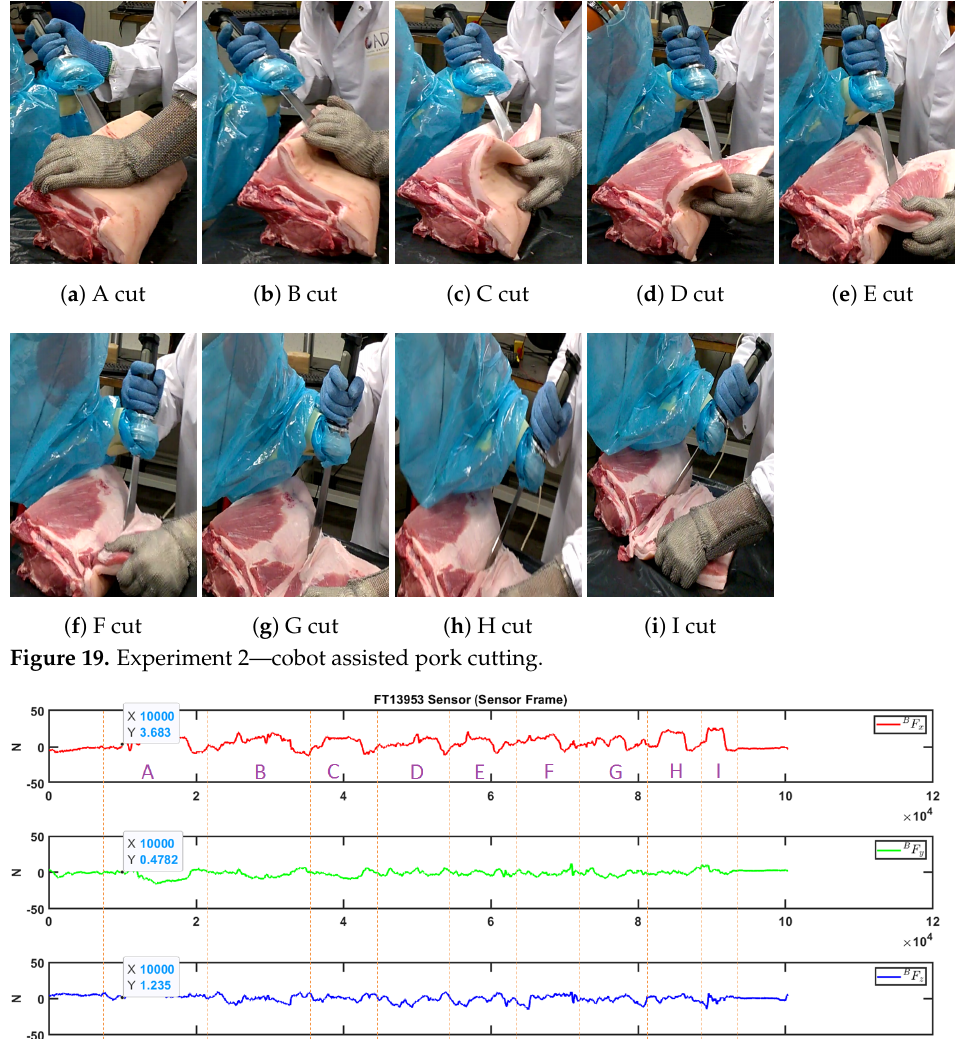
Figure 20. Forces applied by the user in Experiment